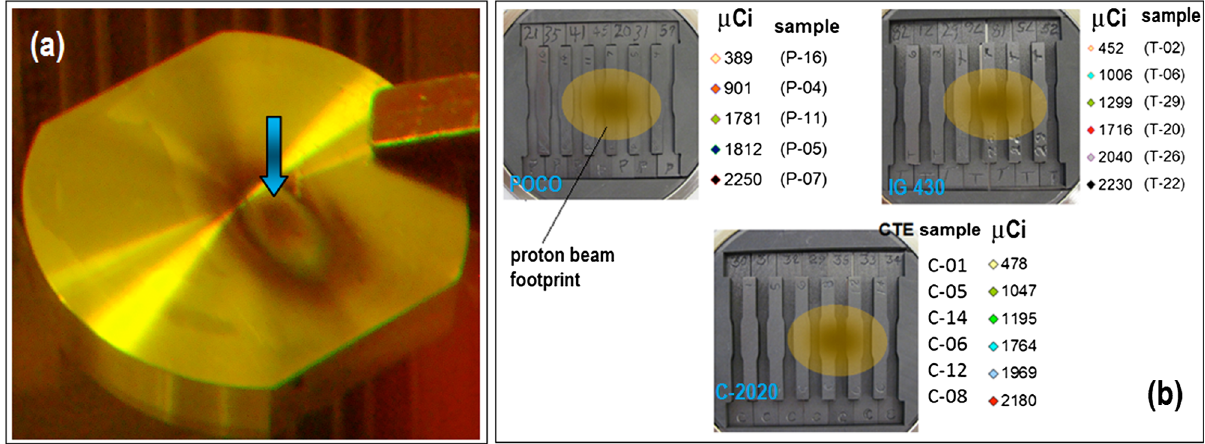
FIG. 5. (a) Imprint of proton beam on the stainless steel window of the vacuum capsule just upstream of the first graphite target capsule in the array, and (b) profile of activation measurements on the CTE-type samples contained in the target capsules conducted following